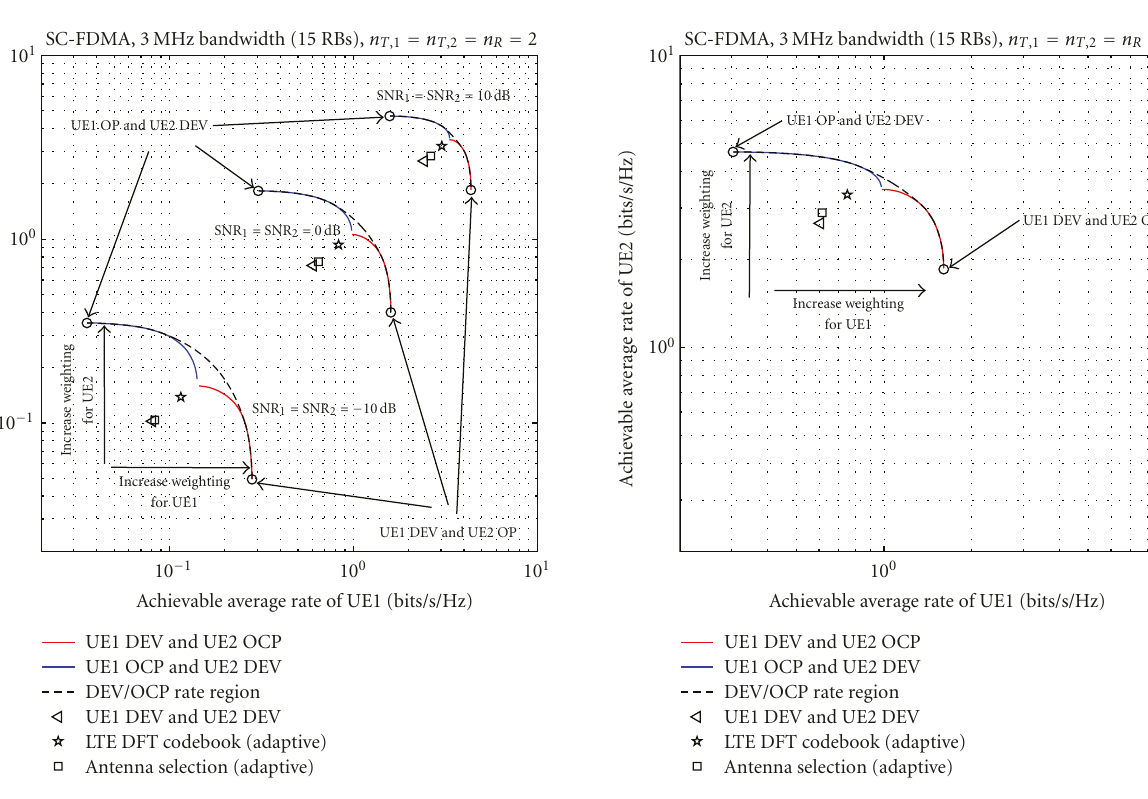
Figure 9: Achievable average rate for two UEs for di ff erent transmit precoding strategies in the SCME “urban macro” scenario accord- ing to Table 1. Both UEs share 3MHz bandwidth to communicate with the serving BS using the same time and frequency resources. Both UEs have the same SNR.